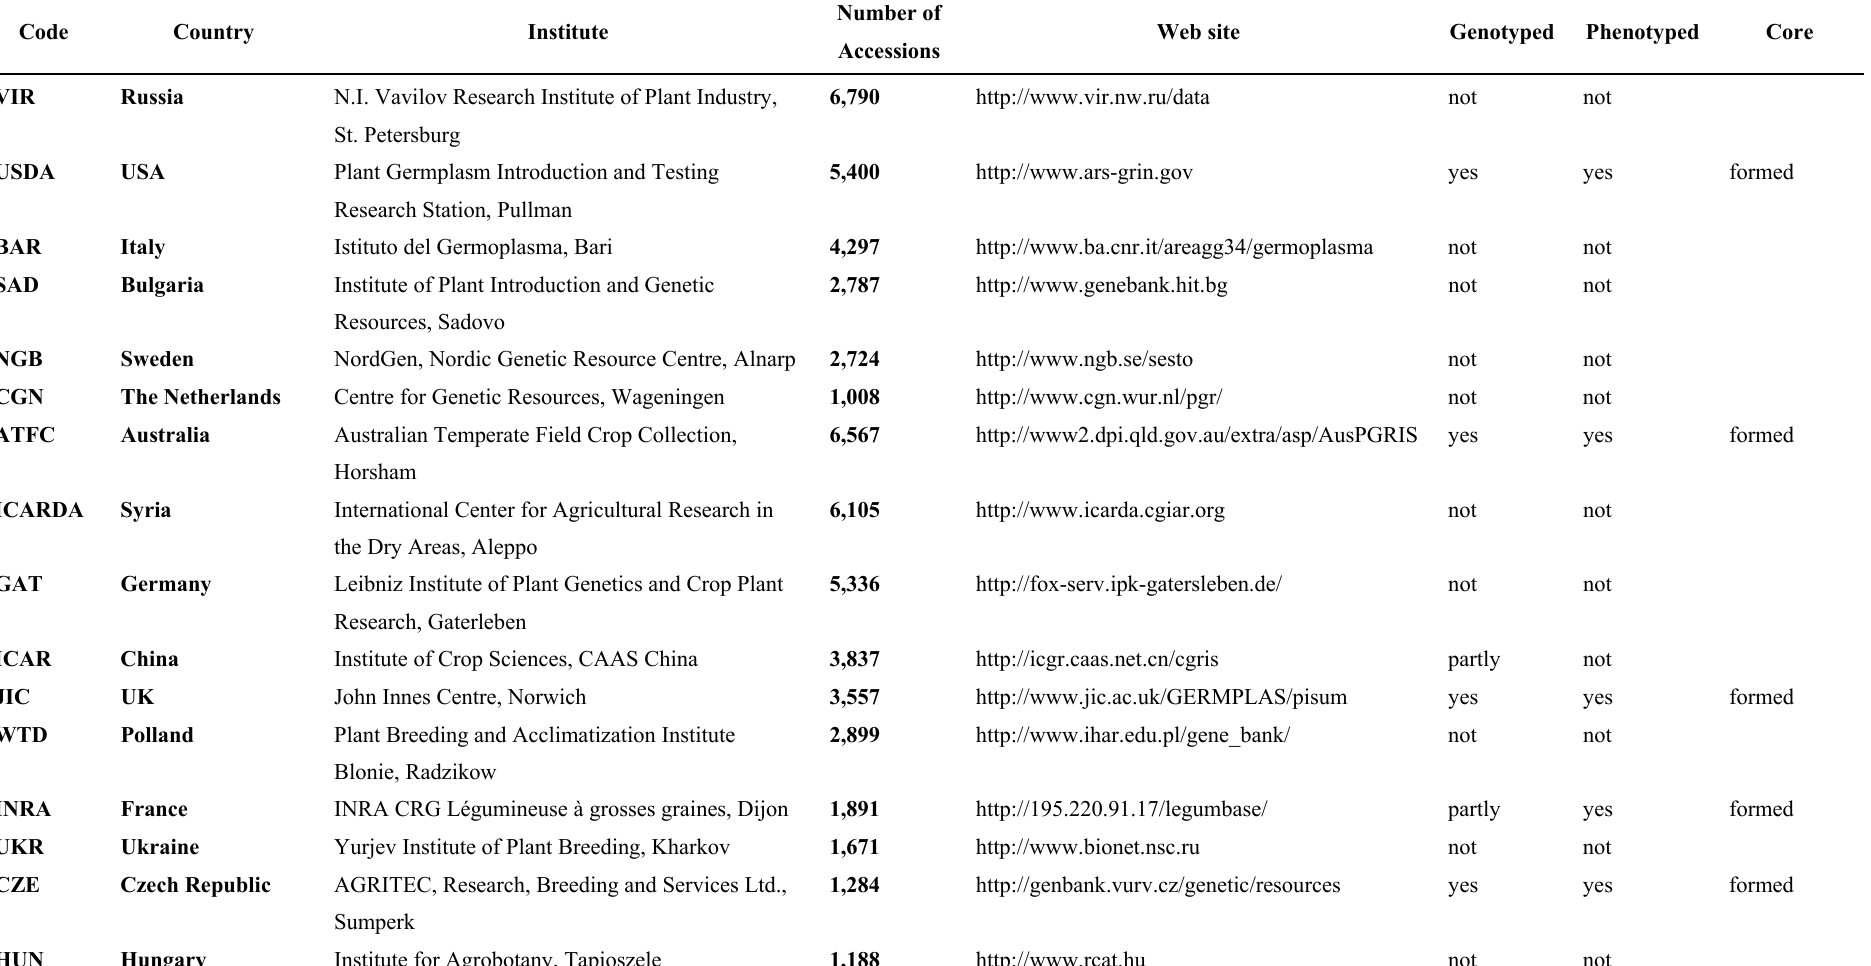
Table 1. List of sixteen major world pea germplasm collections with over 1000 accessions. Collections that have been genotyped, phenotyped or have core collections are